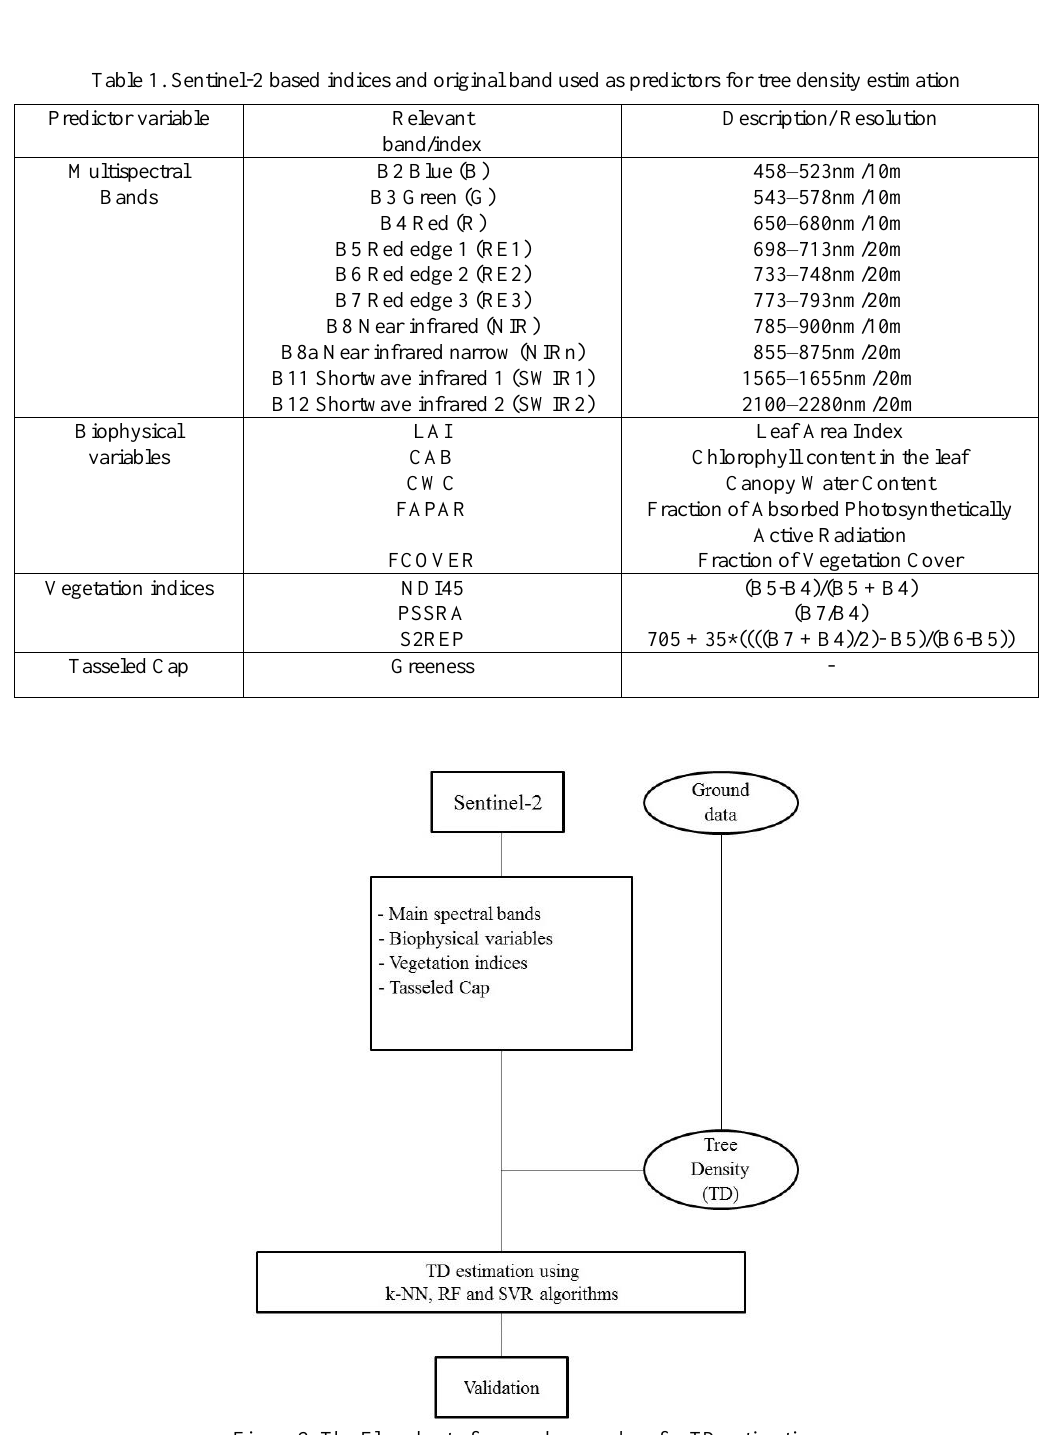
Figure 2. The Flowchart of research procedure for TD